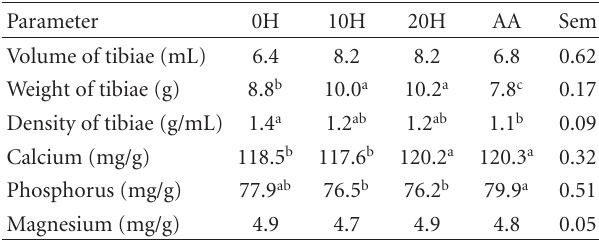
Table 4: E ff ect of honey on mineral deposition in tibiae of broiler chickens during hot-dry